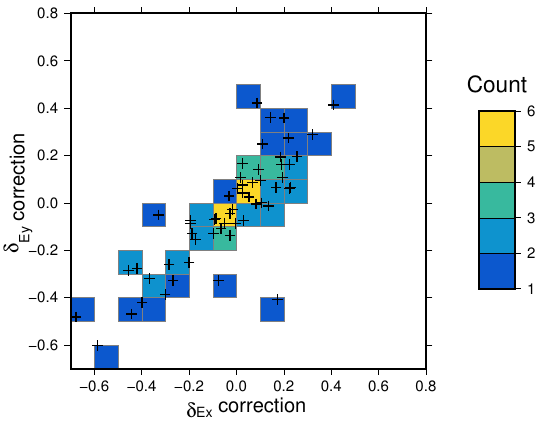
Figure 9. Bivariate distribution of calculated static-shift corrections δ E and δ E in decades (i.e. as additive factors, where + 0.5 corre- x y sponds to a multiplicative factor of 10 0 . 5 , ≈ 3), paired by site. The ≈ δ E strong clustering and 45 ◦ trend (i.e. δ E ) indicate that the or- x y thogonal static shifts are generally similar sized across the survey area, with no observable regional trend of greater static shift of one polarisation.